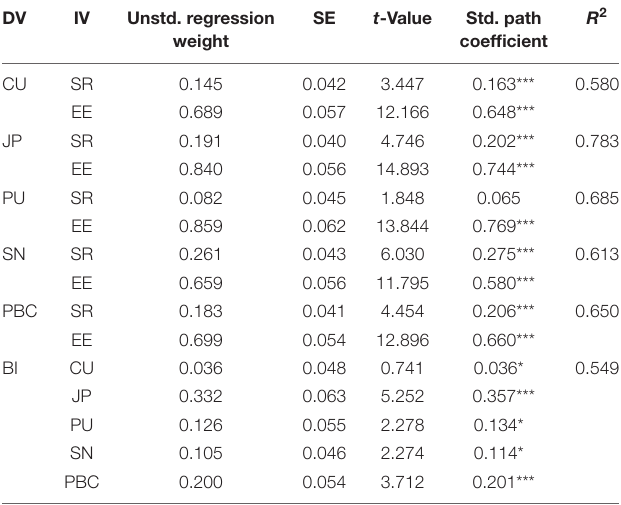
TABLE 4 | Structural model analysis.